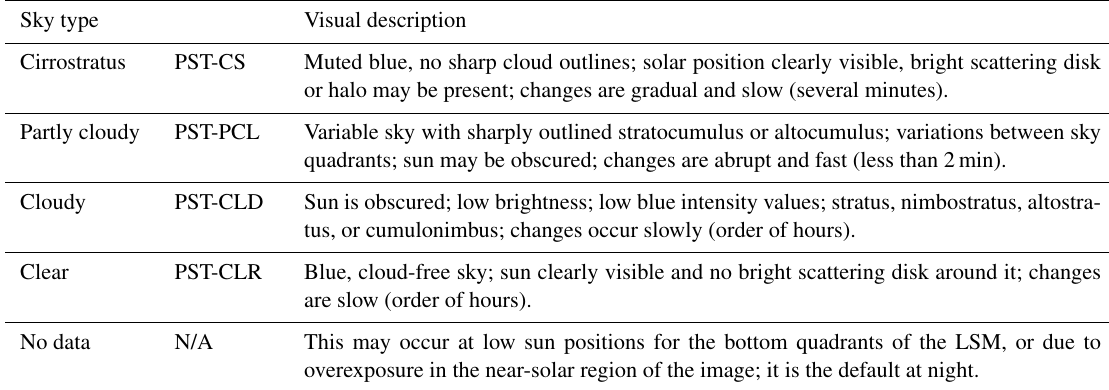
Table 2. Descriptions of the photographic sky types (PST). Sky type Visual description Cirrostratus